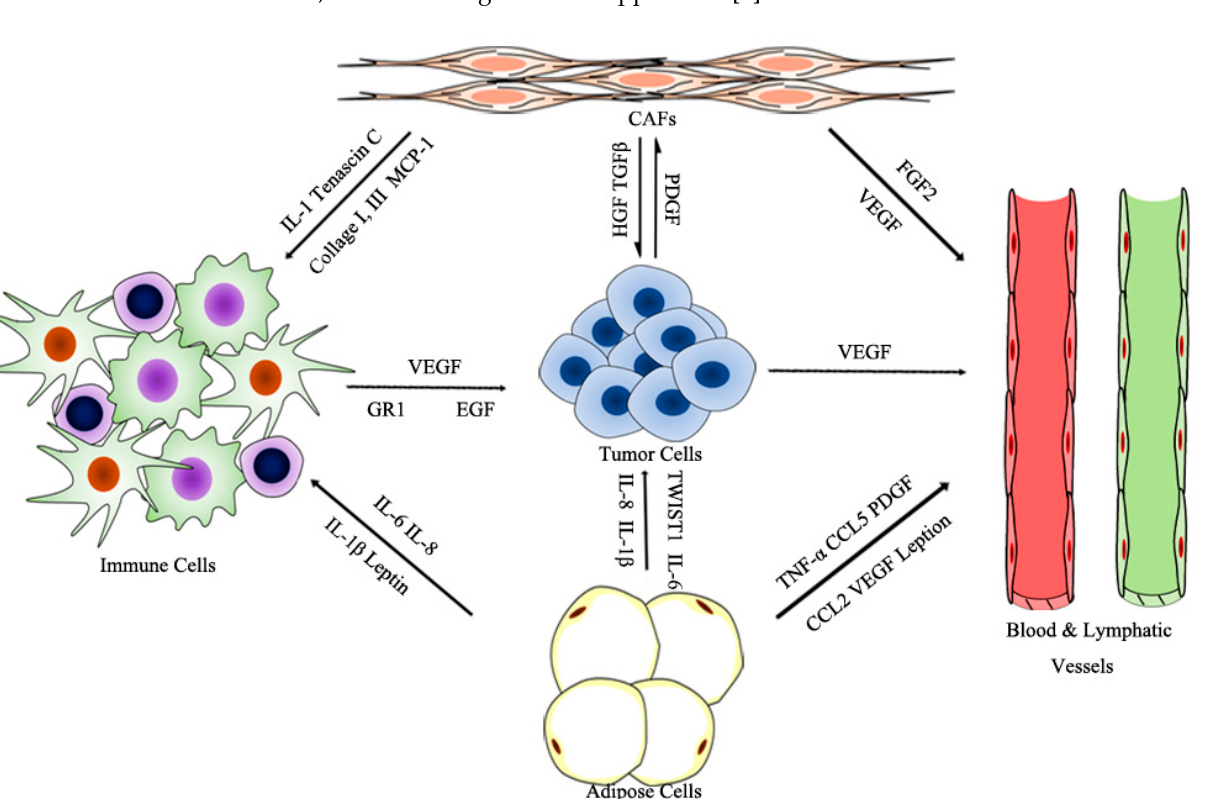
Figure 1. Prominent components of the TME.